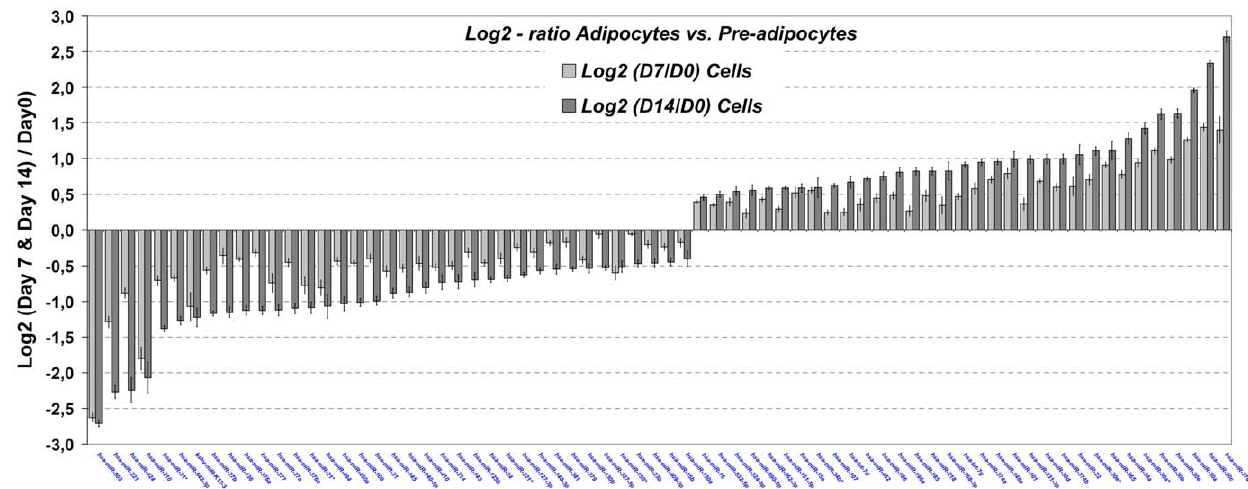
Figure 2. Specific miRNAs expression regulation during adipogenesis. Expressions of miRNAs significantly deregulated during differentiation. MiRNAs expression levels are normalized to an internal control and plotted as fold changes in Log2-ratio scale for day 7 vs. day 0 (grey bars) and day 14 vs. day 0 (black bars). Log2-ratios of 2-class comparisons are symmetric around 0 (while a Log2-ratio of 1 means 2-fold up- regulation, a Log2-ratio of 2 1 means 2-fold down-regulation as compared to day 0 miRNAs levels). Data are expressed as mean 6 SEM (n=6). All the represented miRNAs (70 of the 799 analyzed miRNAs) showed ANOVA P -values , 0.0001 for comparisons between groups and fold-changes over 1.2- fold or under 2 1.2-fold day 0 miRNA expression levels.